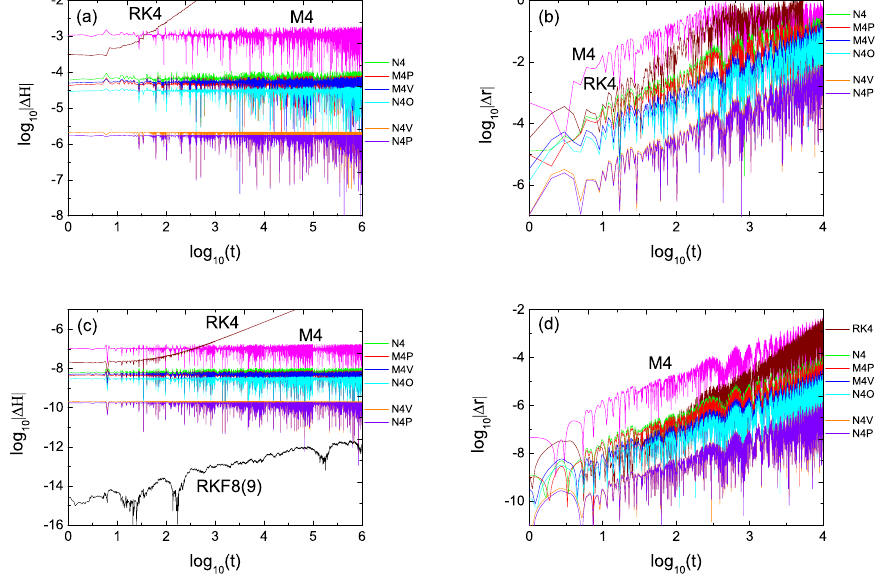
Figure 1. ( a ) Energy errors for several algorithms independently solving the modified Hénon–Heiles system. The time step is τ = 0.1, and energy is E = 1/120. Initial conditions are x = 0, y = − 2.02 and p y = 0. The positive initial value of p x is given by the energy relation E = H . ( b ) Position errors between the solutions of RKF8(9) and the other methods. ( c , d ) are the same as ( a , b ) but a smaller time step τ = 0.01 is used. These errors are clearly listed in Tables 1 and